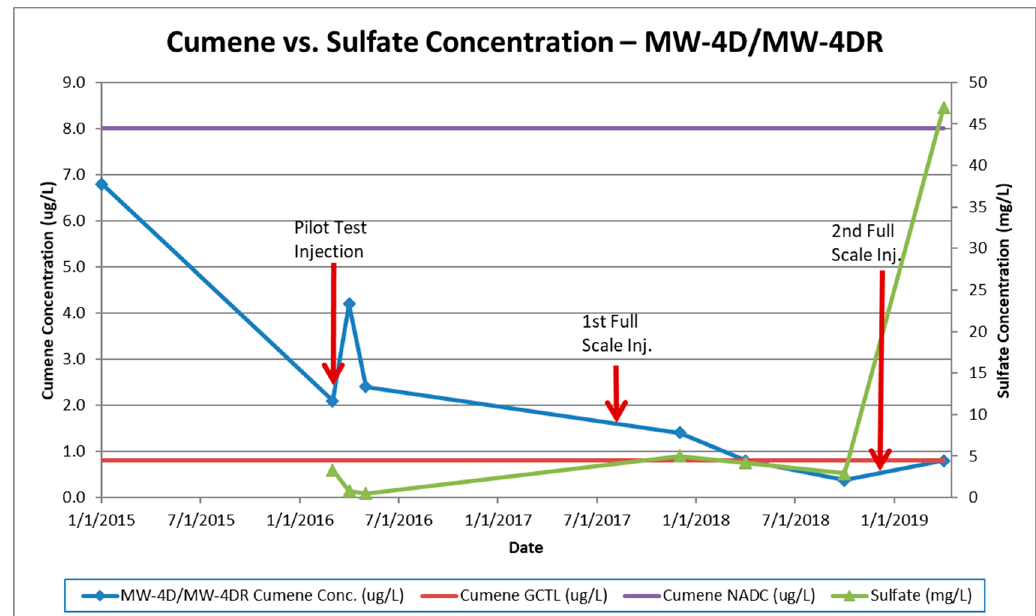
Figure 3. Cumene vs. sulfate concentrations in MW-4D/MW-4DR.